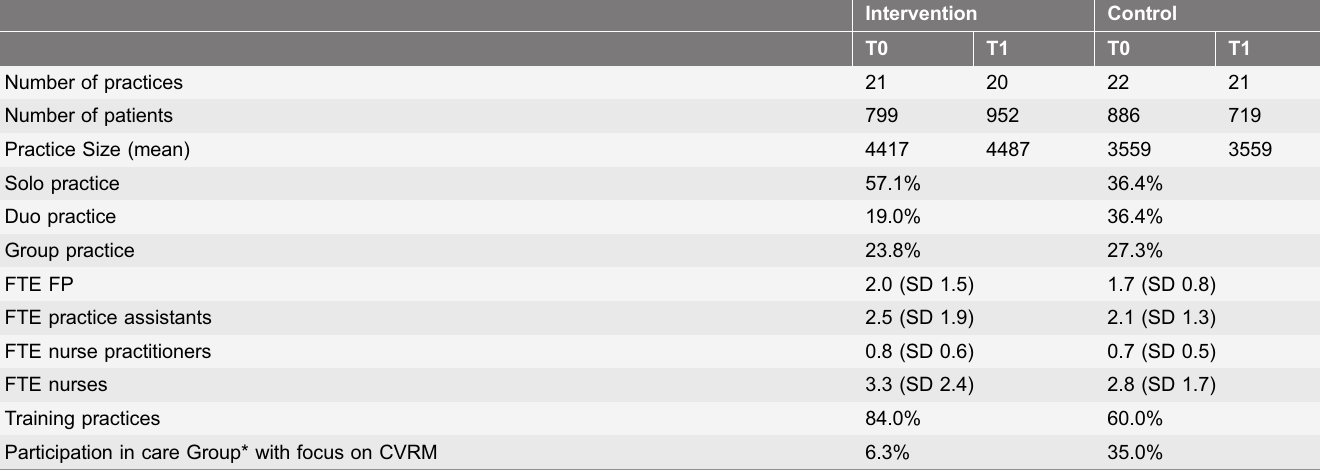
Table 1. Characteristics of Practice Population, Intervention vs. Control group.